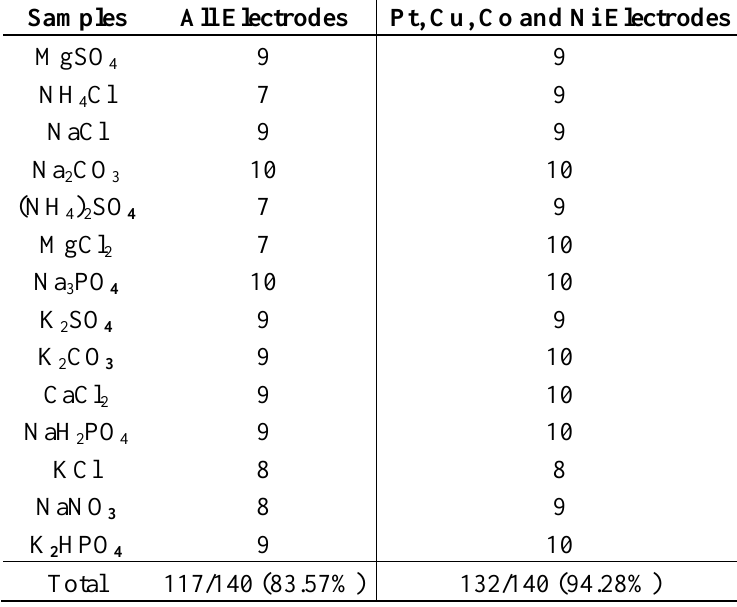
Table 3. Number of successful classification in the discrimination of NH compared with different salts.